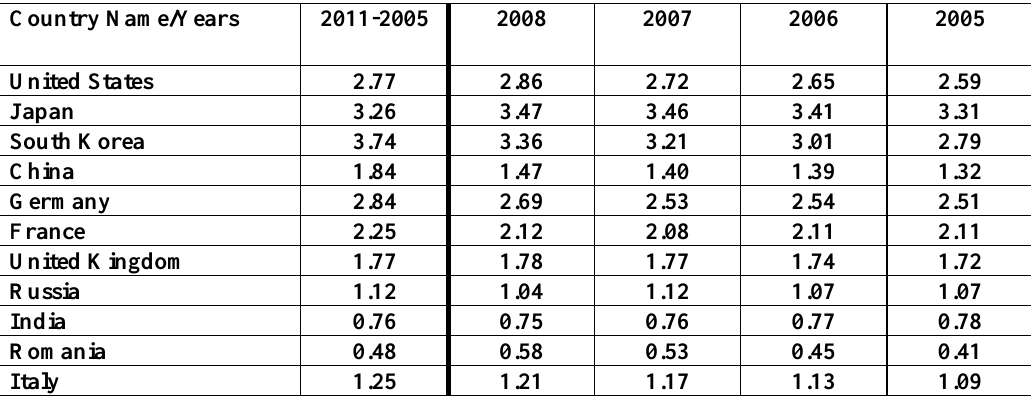
Table 1: R&D Expenditure as a % of GDP Country